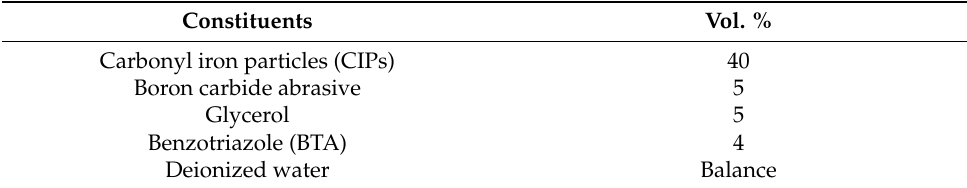
Table 2. MR fluid